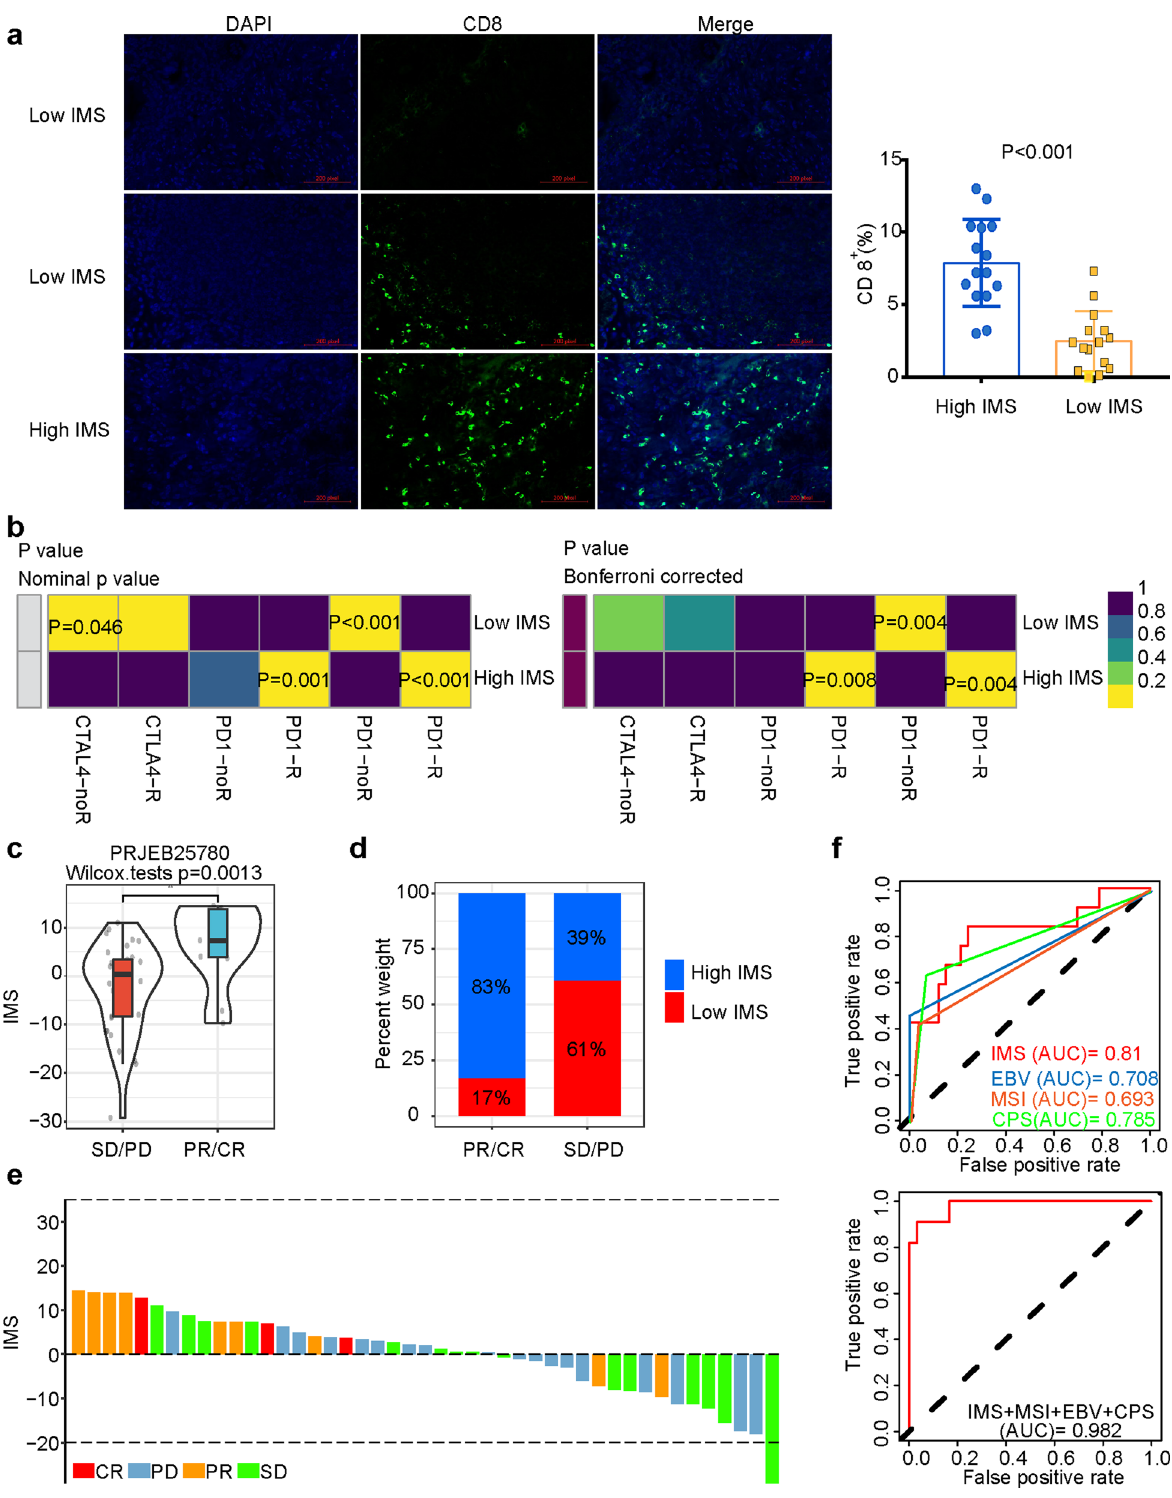
Fig. 6 Prediction of the response to immune checkpoint inhibitor treatment. a Immuno fl uorescence staining revealed that the expression of CD8 T cell in fi ltration and PD-L1 protein in the high IMS group was signi fi cantly higher than that in the low IMS group (Wilcoxon test, P value < 0.05). b The tumor immune dysfunction and exclusion (TIDE) algorithm showed that the high IMS group responded to PD-1/PD-L1 inhibitor treatment ( P value < 0.05), while the low IMS group did not respond to immune checkpoint inhibitor treatment ( P value > 0.05). c The complete response (CR)/partial response (PR) group had a higher IMS than the stable disease (SD)/progressive disease (PD) group (Wilcoxon test, P value = 0.0013). d Proportion of patients responding to PD-L1 inhibitor immunotherapy: CR/PR and SD/PD: 83%/17% in the high IMS group and 39%/61% in the low IMS group ( P value < 0.05, χ 2 test). e Waterfall plot illustrating the IMS according to the immunotherapy response in the PRJEB25780 cohort. f The predictive value of IMS, MSI status, EBV status, and CPS in PD-L1 inhibitor immunotherapy